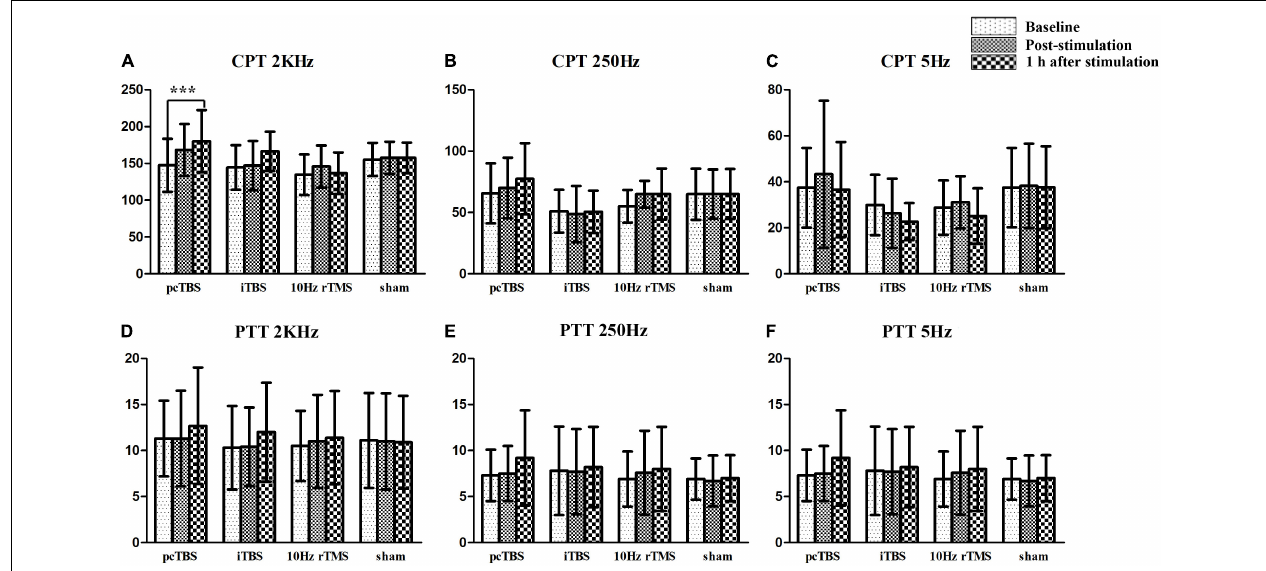
FIGURE 4 | Sensory and pain thresholds measurements. CPT means current perception threshold and PTT means pain tolerance threshold. pcTBS, prolonged continuous theta-burst stimulation; iTBS, intermittent theta-burst stimulation; rTMS, repetitive transcranial magnetic stimulation. *** P <